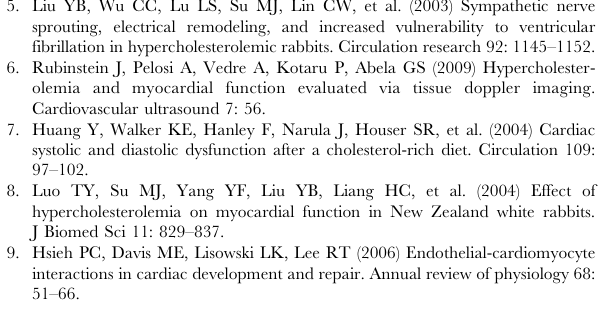
Table S1 Overview of Taqman gene expression assays used for quantitative reverse transcriptase polymerase chain reaction.